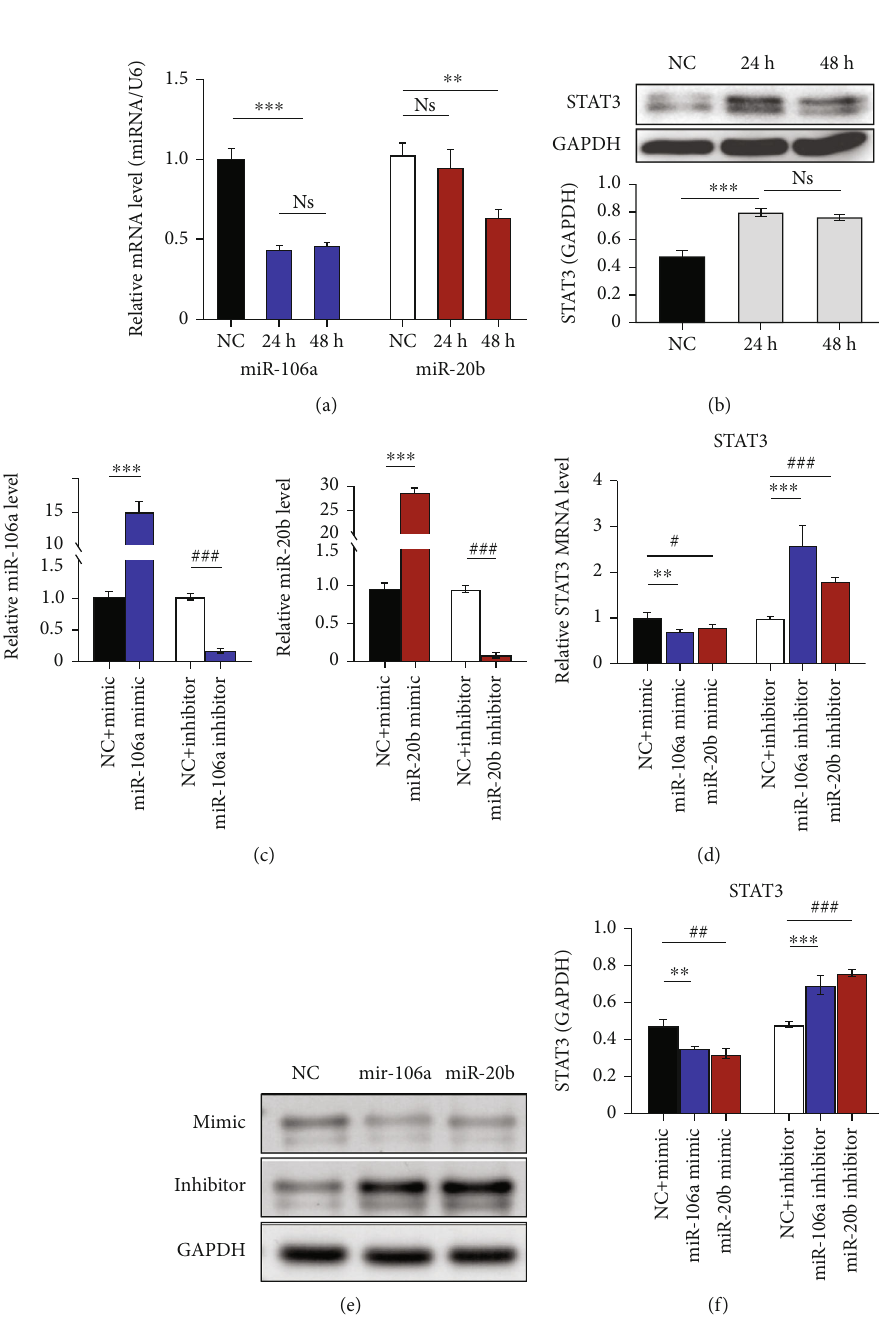
Figure 7: Relative expression levels of miR-106a, miR-20b, and STAT3 mRNA in DCs after loading with GSCs. (a) miR-106a/20b expression was determined in the NC group and after 24 and 48h of GSC stimulation by real-time PCR. (b) STAT3 mRNA expression was determined in the NC group and after 24 and 48 h of GSC stimulation by Western blotting. (c) Relative expression levels after miR- 106a/20b mimic or inhibitor transfection in DCs. (d) RT-PCR of STAT3 expressions in each DC-transfected group after 12h of GSC stimulation. (e and f) Western blotting analysis of STAT3 protein expression in each DC-transfected group. ∗∗ p < 0 : 01 , ∗∗∗ p < 0 : 001